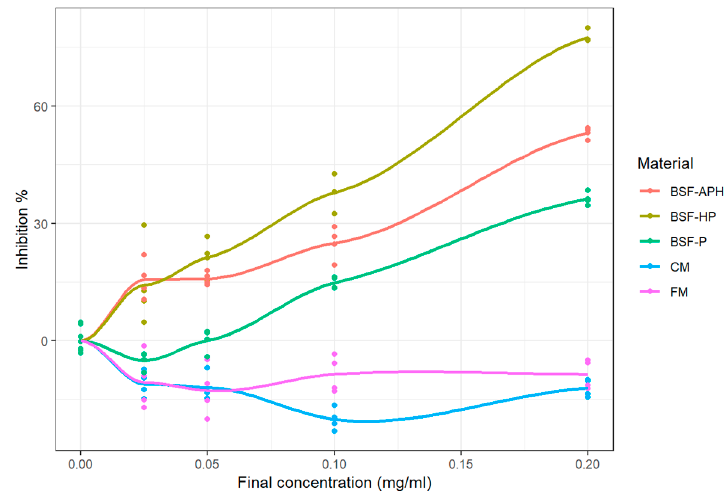
Figure 3. MPO response modulation activity of PureeX TM (BSF-P), PureeX proTM (BSF-HP), ProteinAX proTM (BSF-APH), chickenmeal (CM), and fishmeal (FM) using specific immunological extraction followed by enzymatic detection (SIEFED) assay (n = 3).